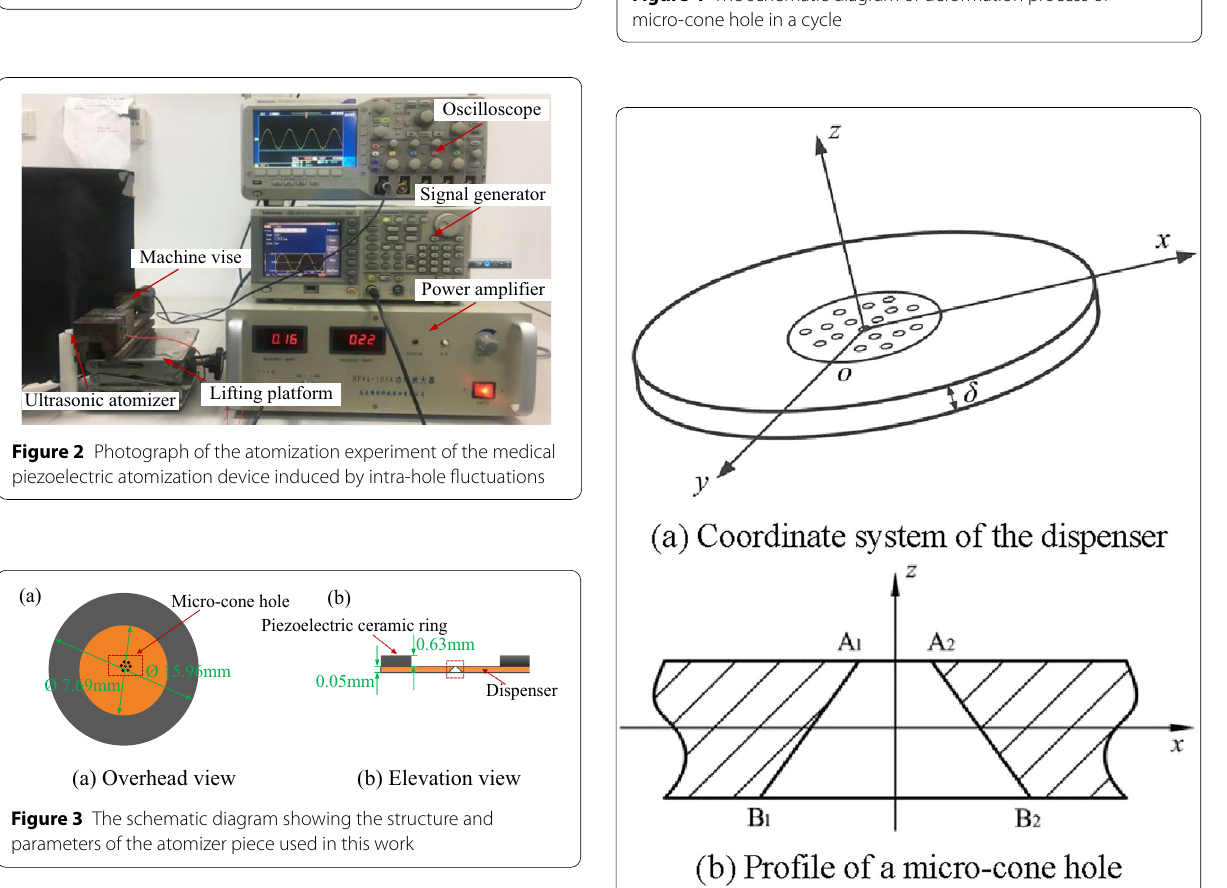
Figure 5 Schematic diagram of coordinate settings of the dispenser